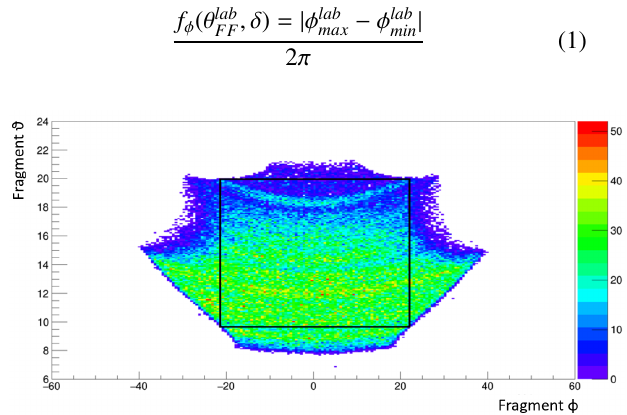
Figure 2. Selected window in ✓ and φ for a central B ⇢ range ( δ = 0.9975 - 1.0025) for VAMOS setting B ⇢ = 1.24 Tm, ✓ = 14 ◦ to calculate the φ -angular acceptance, f φ ( ✓ lab